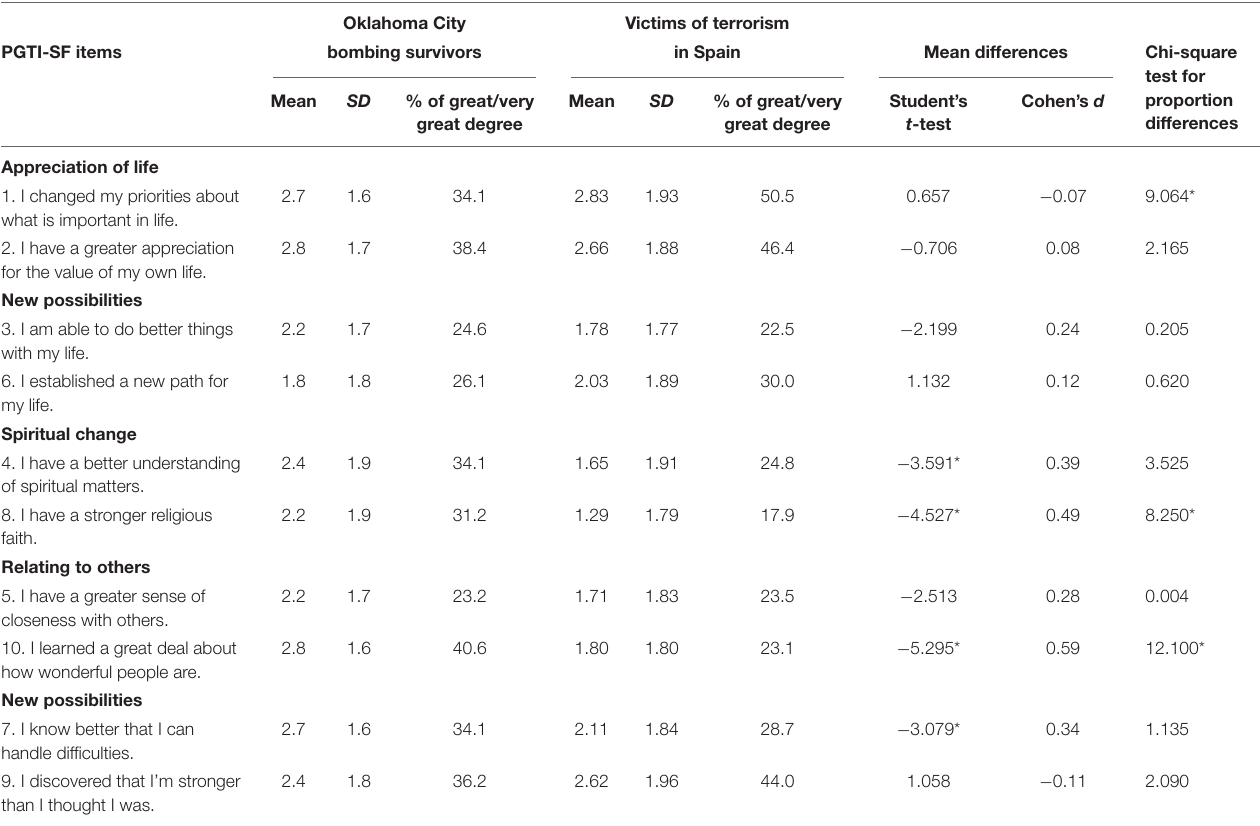
TABLE 1 | Mean scores and percentages of “great/very great degree” responses in the PTGI-SF items: Oklahoma City bombing survivors ( N = 138; Tucker et al., 2016) vs. victims of terrorism in Spain ( N =